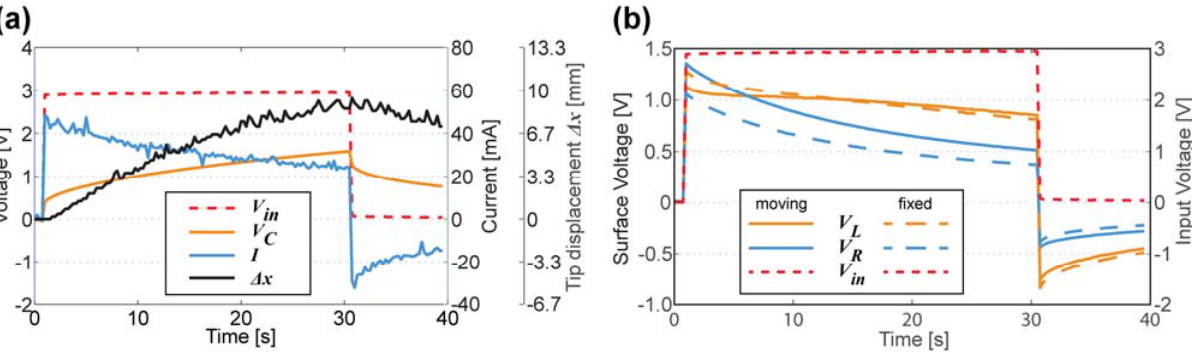
, voltage drop on separator V , current I , and tip in C